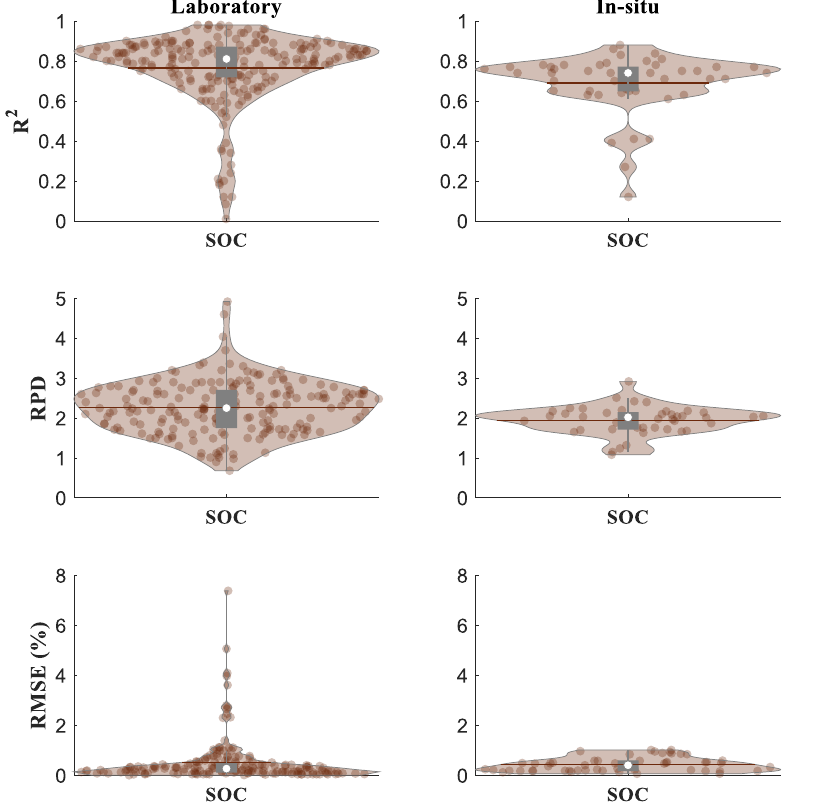
Figure 10. Statistical measures for SOC predicted by V-NIR spectroscopy in laboratory versus in-situ .